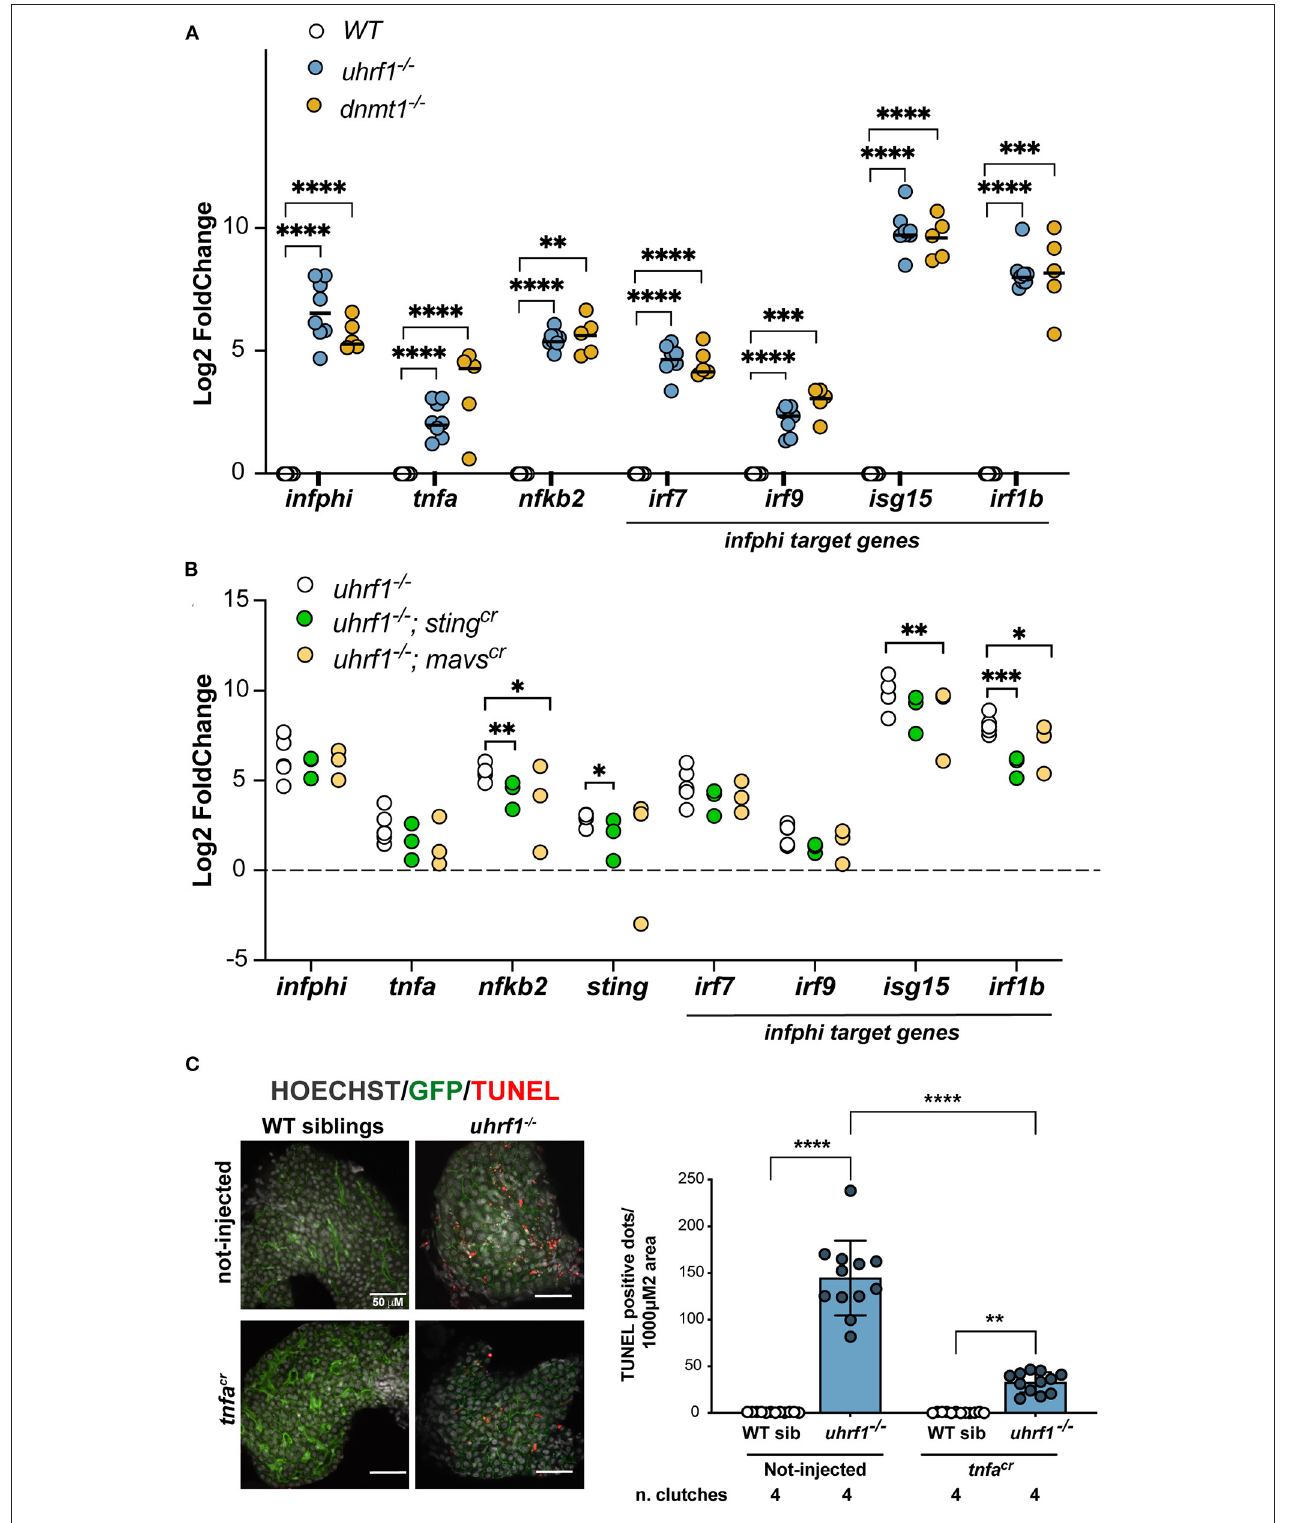
FIGURE 5 | Viral signaling pathways are required for the gene expression and cell death phenotypes in uhrf1 mutants. ( A) qPCR analysis of immune genes in uhrf1 − / − and dnmt1 − / − mutants compared to their WT siblings. Rplp0 is used as loading controls and the delta-delta Ct (DDCt) values were calculated by normalization